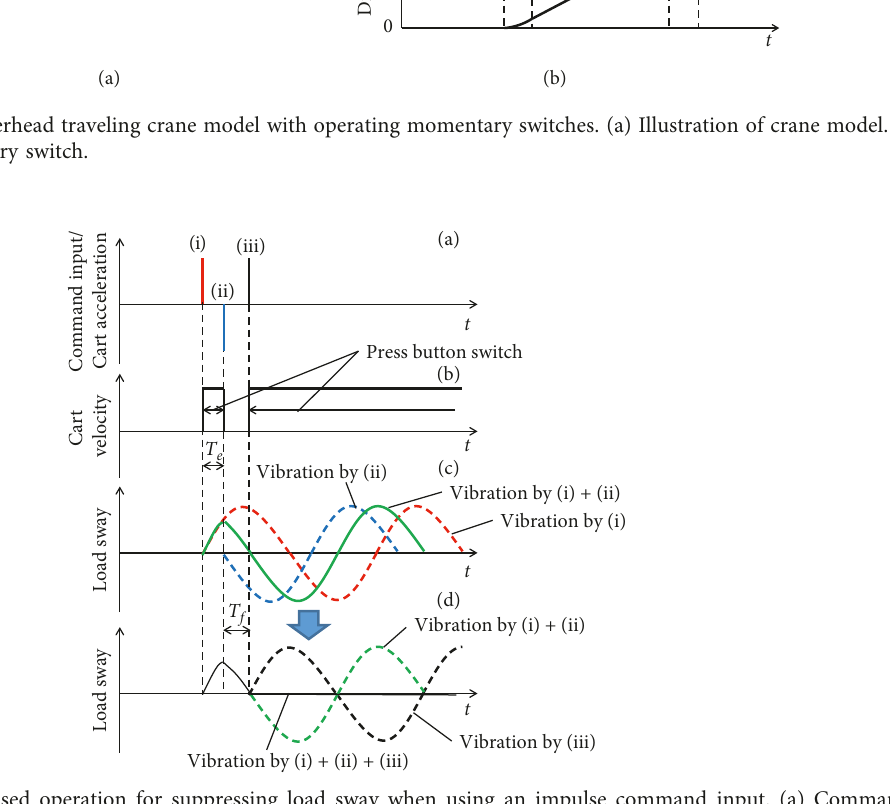
Figure 4: Overview of proposed operation for suppressing load sway when using an impulse command input. (a) Command input regarding as the cart acceleration with (i) acceleration generated by pressing the momentary switch, (ii) deceleration generated by releasing the momentary switch, and (iii) acceleration generated by re-pressing the momentary switch. (b) Cart velocity. (c) Load sway occurred by the cart accelerations (i) and (ii). (d) Load sway occurred by the cart accelerations (i), (ii), and (ii).